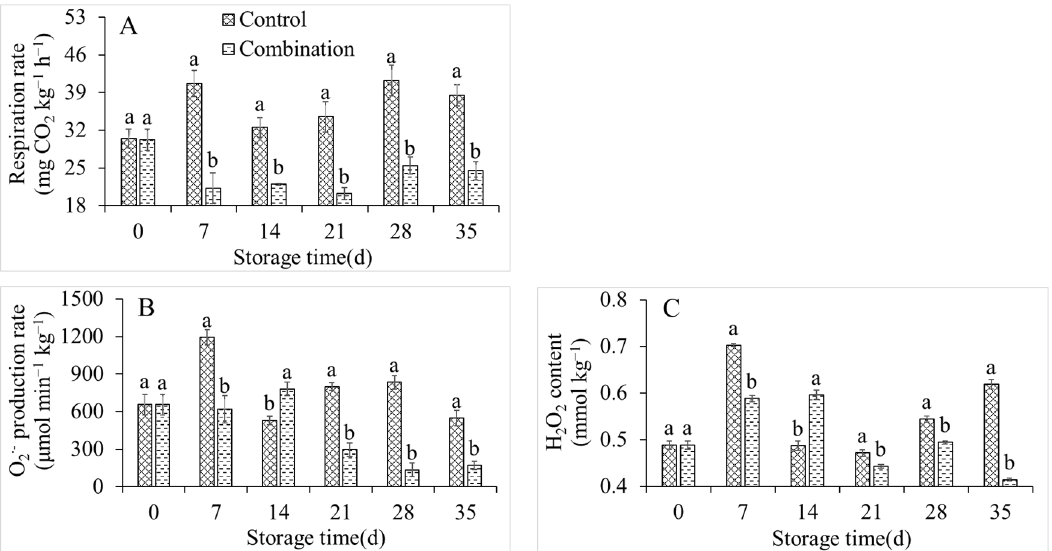
Figure 3. Respiration rate ( A ), O 2 − production rate ( B ), and H 2 O 2 content ( C ) of peaches during storage at 5 °C. Vertical bars indicate the standard errors of three replications. Different lowercase letters at same storage time points are significantly different ( p < 0.05).